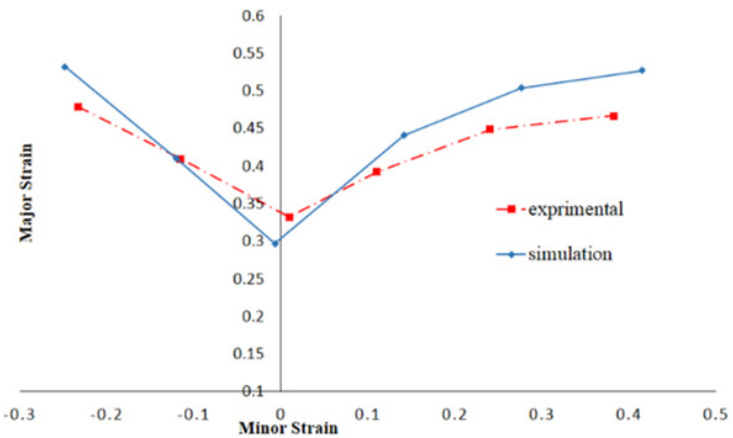
Figure 11. Comparing the experimental and simulated FLDs for a 3 mm-thick AA 6061 sheet at 100 mm/min speed.